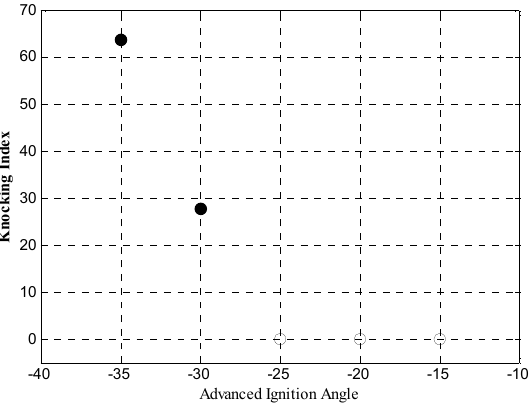
Figure 25. Knocking index with different advanced ignition angle.